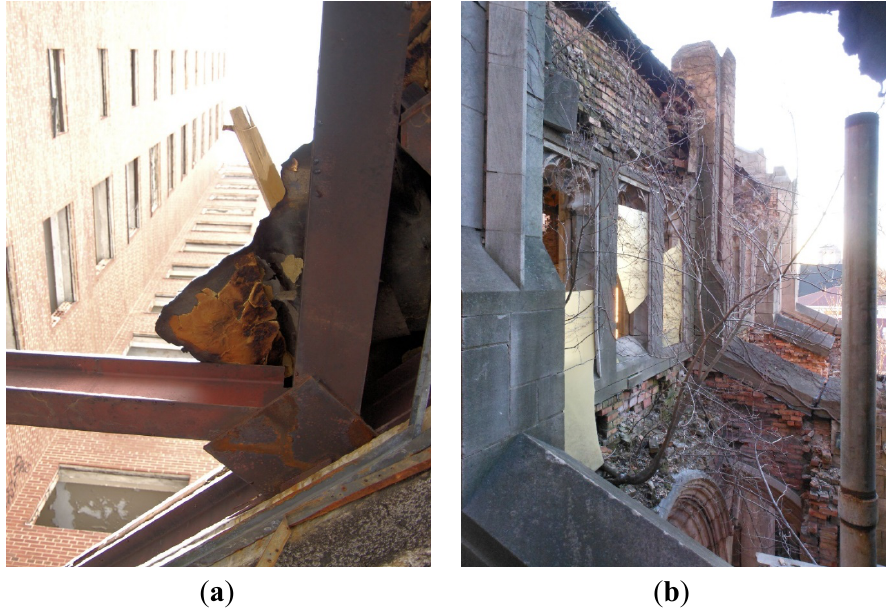
Figure 8. Gary Methodist Church, Gary ( a )—Brewster-Douglass Housing Projects, Detroit ( b